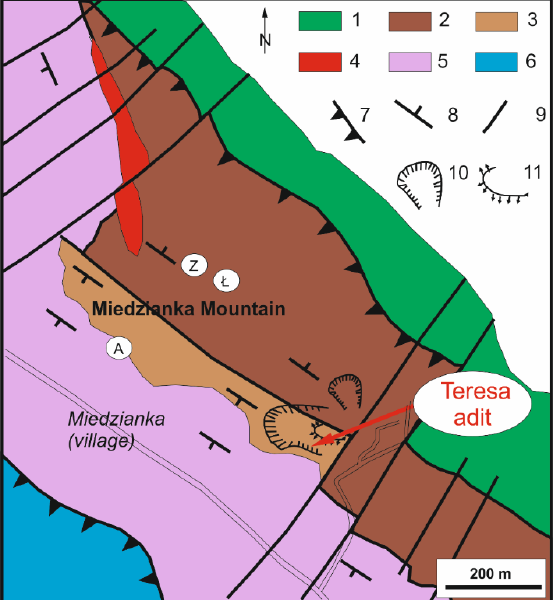
Figure 2. Geological map (without Cenozoic deposits) of the Miedzianka Mountain region after [21,31], simplified with the location of some shafts and adits: 1, Lower Cambrian (mudstones and sandstones); 2, Middle Devonian–Givetian (massive limestones); 3, Upper Devonian–Frasnian and Famennian (limestones with marly shales); 4, Permian (conglomerate); 5, Triassic (sandstones and mudstones); 6, Jurassic (limestones); 7, overthrust; 8, bed strike; 9, faults; 10, quarries; 11, heap; Z, Zofia adit; Ł, Łaszczyńscy adit; and A, Austrian shaft. The red arrow points to the location of the Teresa adit, studied in this article.